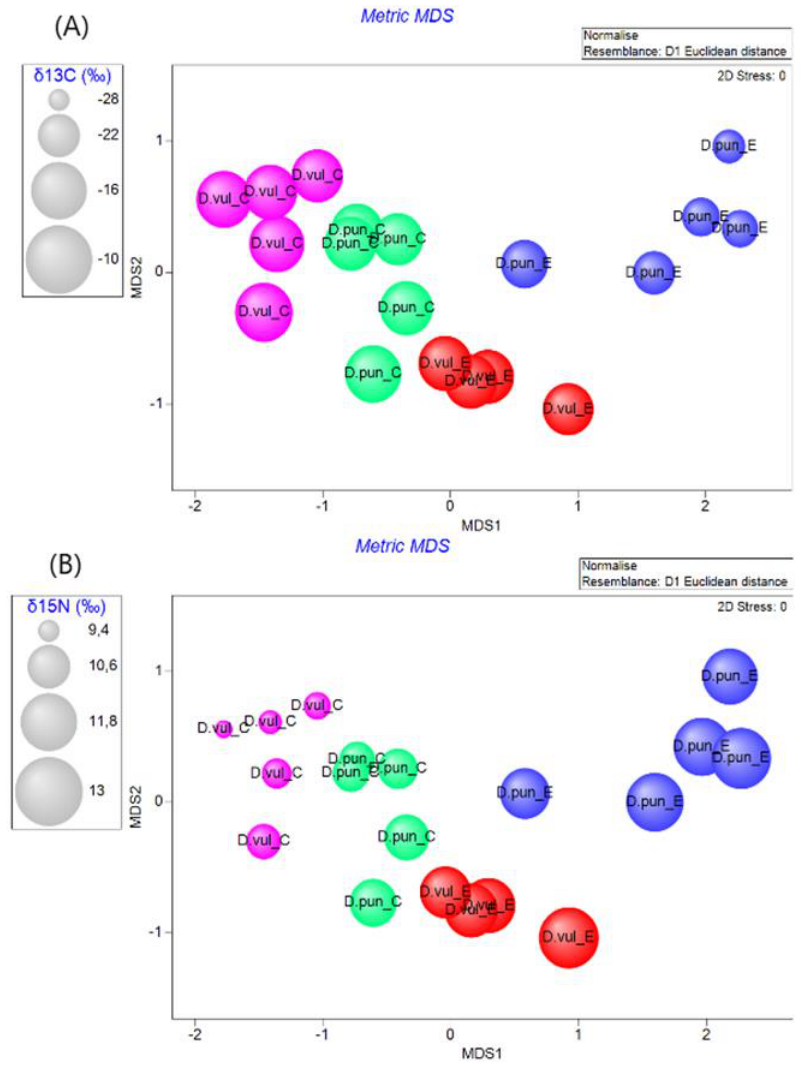
Figure 5. Metric MDS for juvenile Diplodus puntazzo and Diplodus vulgaris as a bubble plot for stable isotopes ( A ) δ 13 C and ( B ) δ 15 N for the coastal waters (C) and estuarine (E). Separate CAP analysis for each of the two factors (“Site” and “Species”) gave success- ful discrimination for species but not for sites. In particular, 80% D. puntazzo specimens were correctly allocated based on the otolith chemistry information, as opposed to 77.8% of D. vulgaris specimens. The two-way CAP plot obtained by merging output scores for the CAP analysis of “Site” and “Species” showed separation of the two species (Figure 6). It is apparent that the site differences (“E” estuary vs. “C” coastal) were able to distinguish for D. vulgaris . In contrast, the D. puntazzo samples from the estuary were consistently clustered, while coastal samples were more variable, making them difficult to